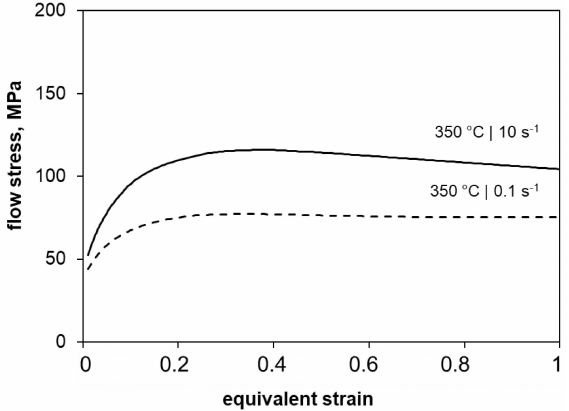
Figure 1. Flow curve of the twin-roll cast and homogenized ZAX210 alloy deformed by the plane strain compression test at 350 ◦ C under a strain rate of 0.1 s − 1 and 10 s − 1 .